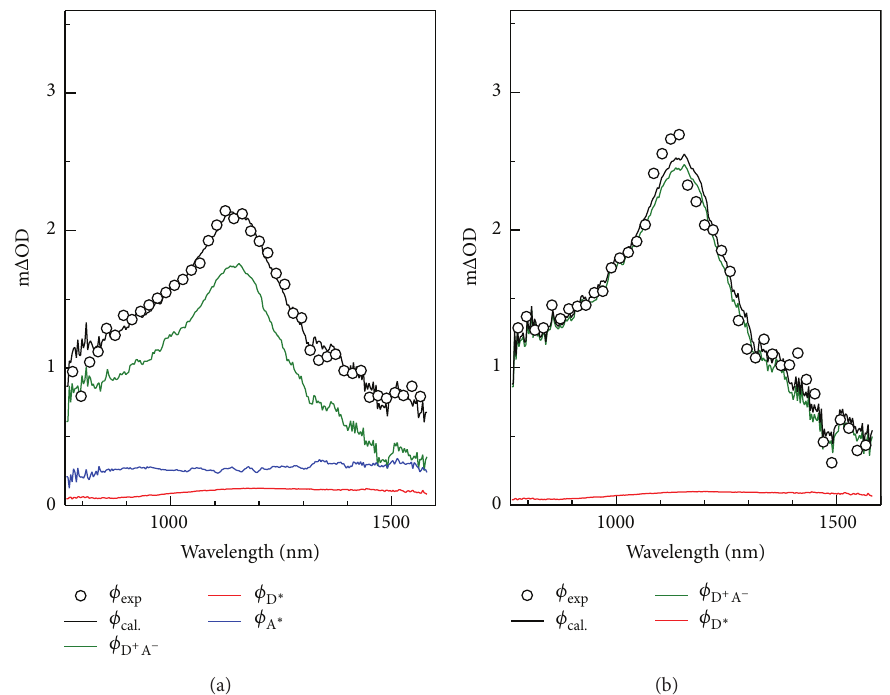
Figure 6: Δ OD spectra of PTB7/PC 71 BM blend film at (a) 0.3ps and (b) 2.7ps at 300 K. Solid curves are results of the decomposition into 𝜙 𝜙 𝜙 D + A − , A ∗ , and D ∗